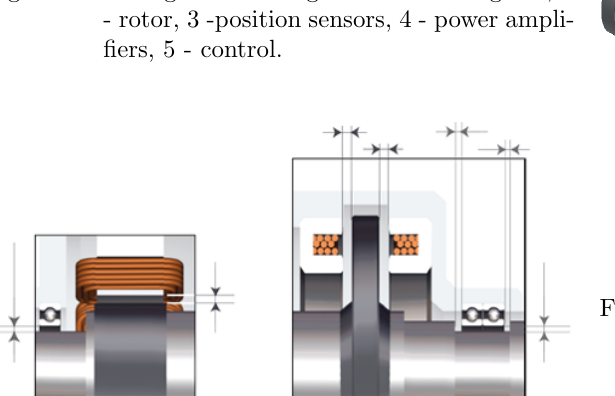
Figure 12: The modelled turbomolecular pump spindle with a simplified fan wheel to the left. The yellow part in the centre is the electric ro- tor. The magnetic bearings are indicated as blue segments and their corresponding po- sition sensors in green. The landing bear- ing modelled in BEAST (not shown in the drawing) is located close to the left position